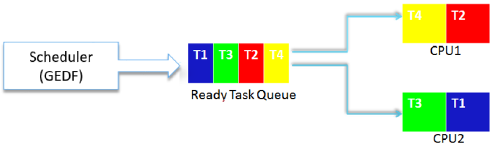
Figure 6. Tasks Scheduling Scheme of HEEPS.